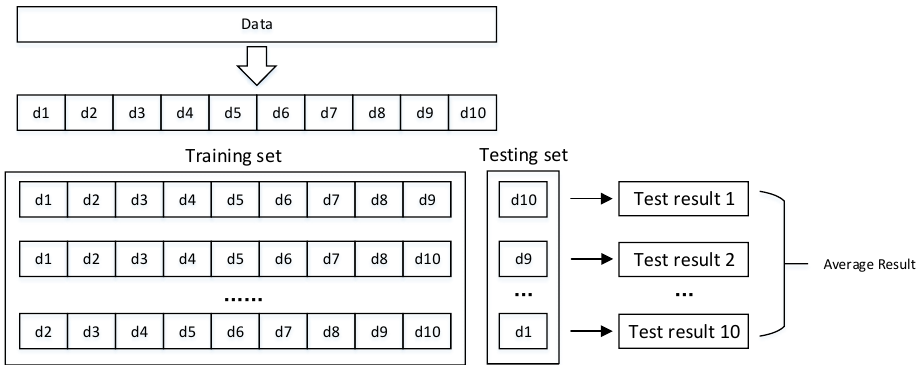
Figure 5. Schematic of 10-fold cross-validation method repeated 10 times.